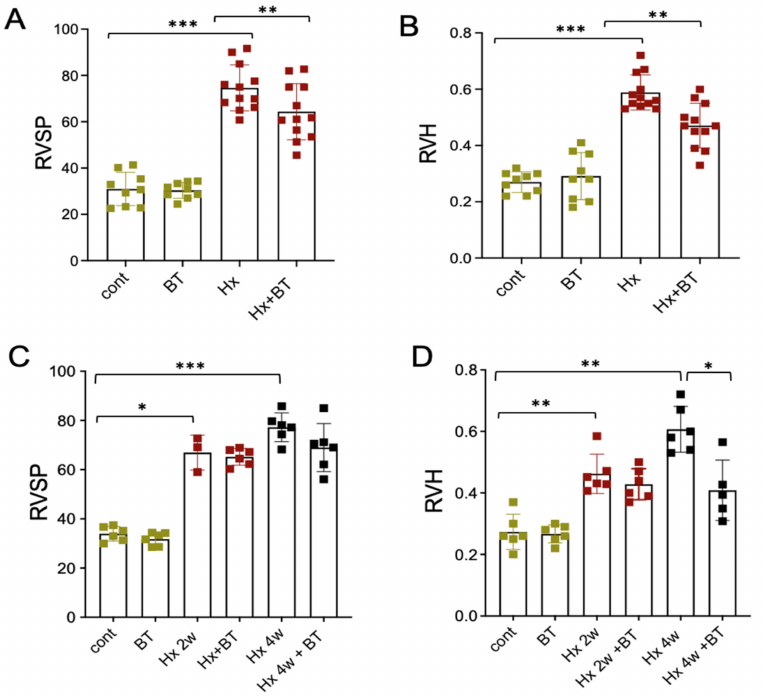
Figure 1. Effects of butyrate treatment on RVSP and RV heart hypertrophy in hypertensive hypoxic SD rats. ( A , B ): Animals were subjected to hypoxic conditions (Hx) or remained at Denver altitude (cont) as for 4 weeks described in the “Materials and Methods”. Butyrate (BT) was given in drinking water at the concentration of 220 mg/kg. Hemodynamic studies and evaluation of RV hypertrophy (Fulton index, RV/LV + S) were performed at the end of the experiments (cont and BT groups (n = 9), Hx and Hx + BT groups (n = 12)); ( C , D ): Animals were subjected to control (cont) or hypoxic (Hx) conditions for 2 and 4 weeks. Part of the animals from these groups were used for RVSP and RV hypertrophy measurement. The other part received butyrate treatment (BT, Hx + BT) for additional 2 weeks, (cont and BT groups (n = 6), Hx (2 weeks n = 3, 4 weeks n = 6), and Hx + BT groups (n = 6)). Data represent a mean +/ − SED; * p < 0.05, ** p < 0.01, *** p <